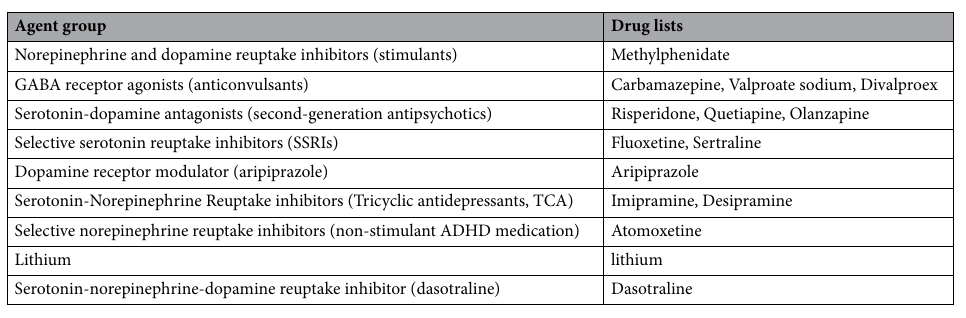
Table 1. The list of medications in each category in our